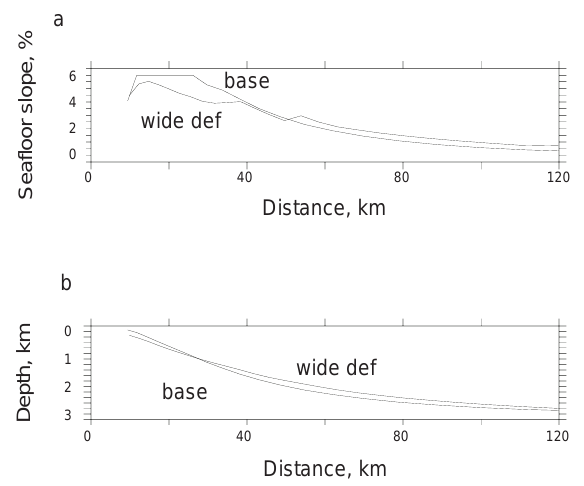
Fig. 3. (a) Sea floor slope and (b) sea floor depth for the Base and Wide Def simulations. Wide Def never reaches the critical sea floor slope of 6%, and so the slope gets monotonically steeper as the simulation approaches the